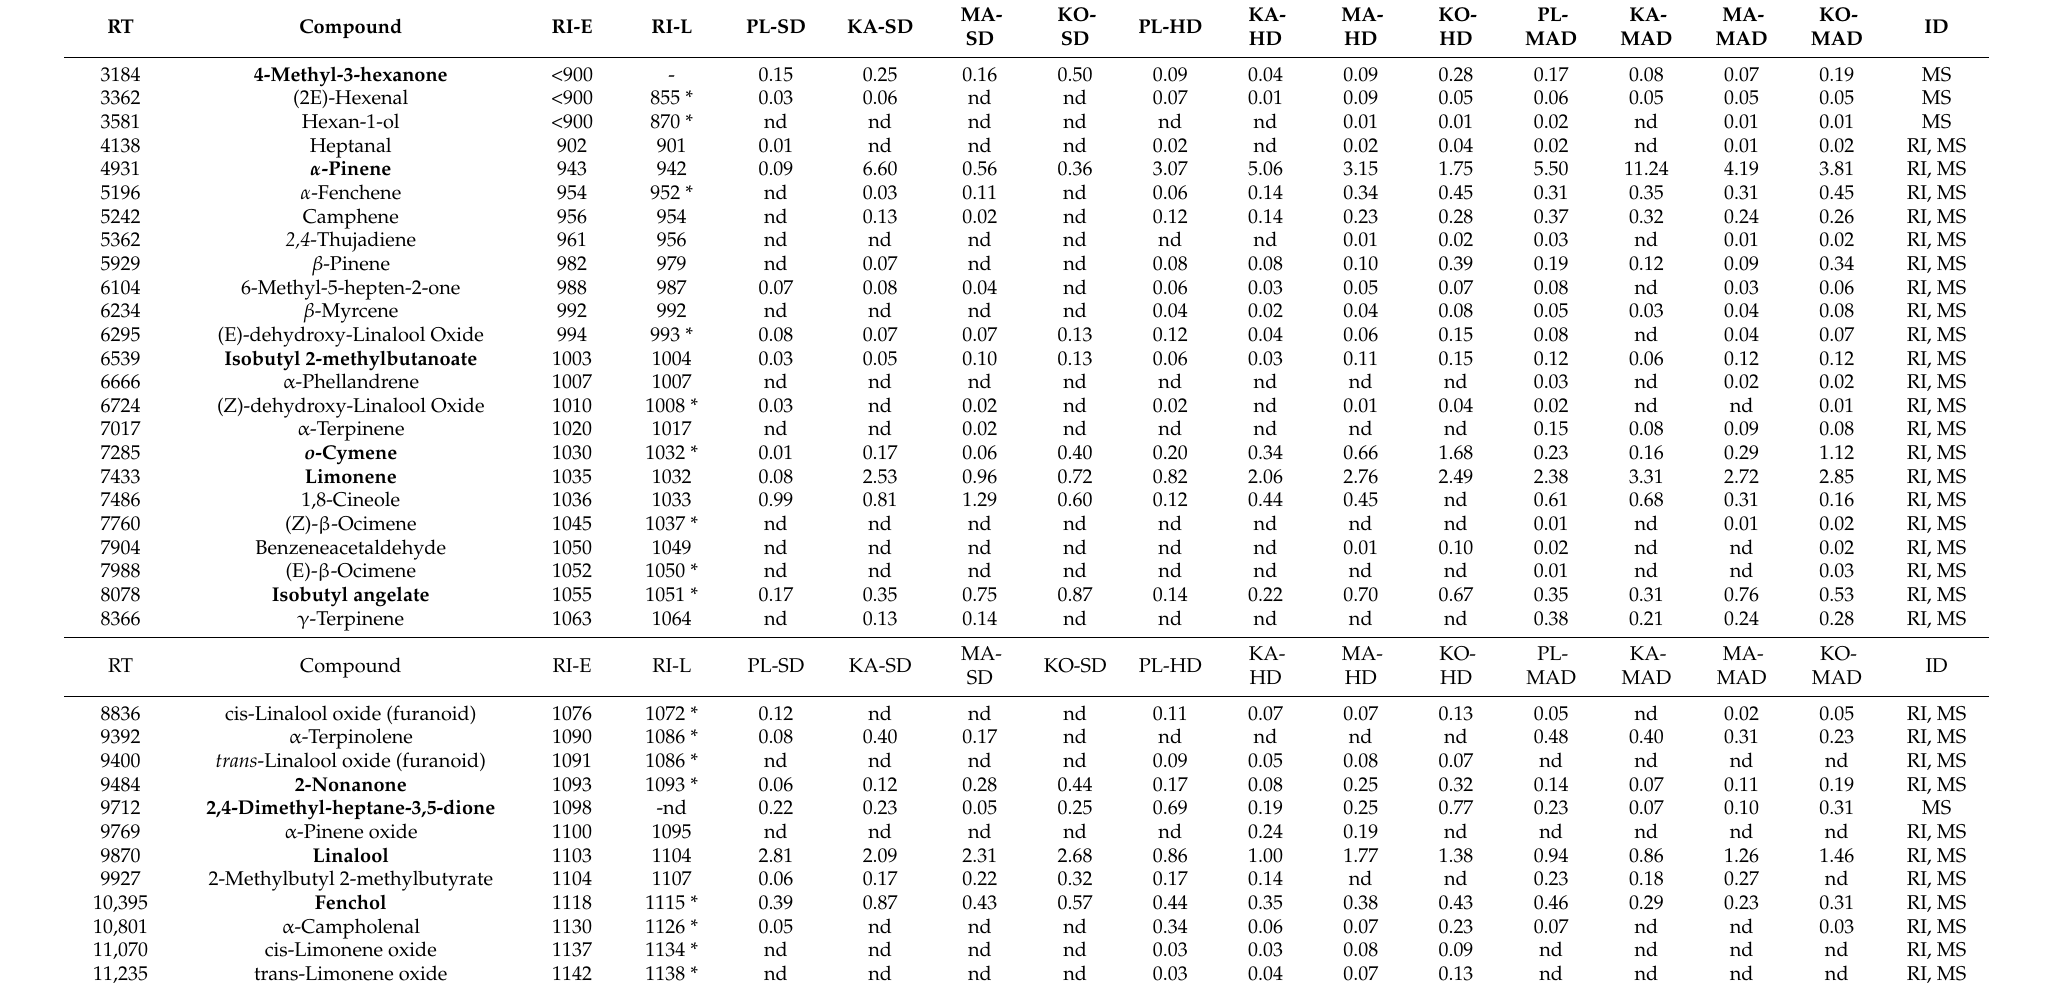
Table 2. Chemical composition of essential oils of H. italicum (Roth) G. Don. The proportion of the compounds is expressed in